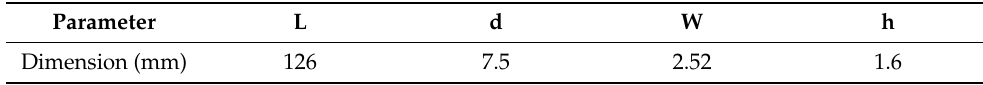
Figure 1. Configuration of the proposed antenna: ( a ) schematic and ( b ) physical representation. Table 1. Design parameters of the antenna (unit: